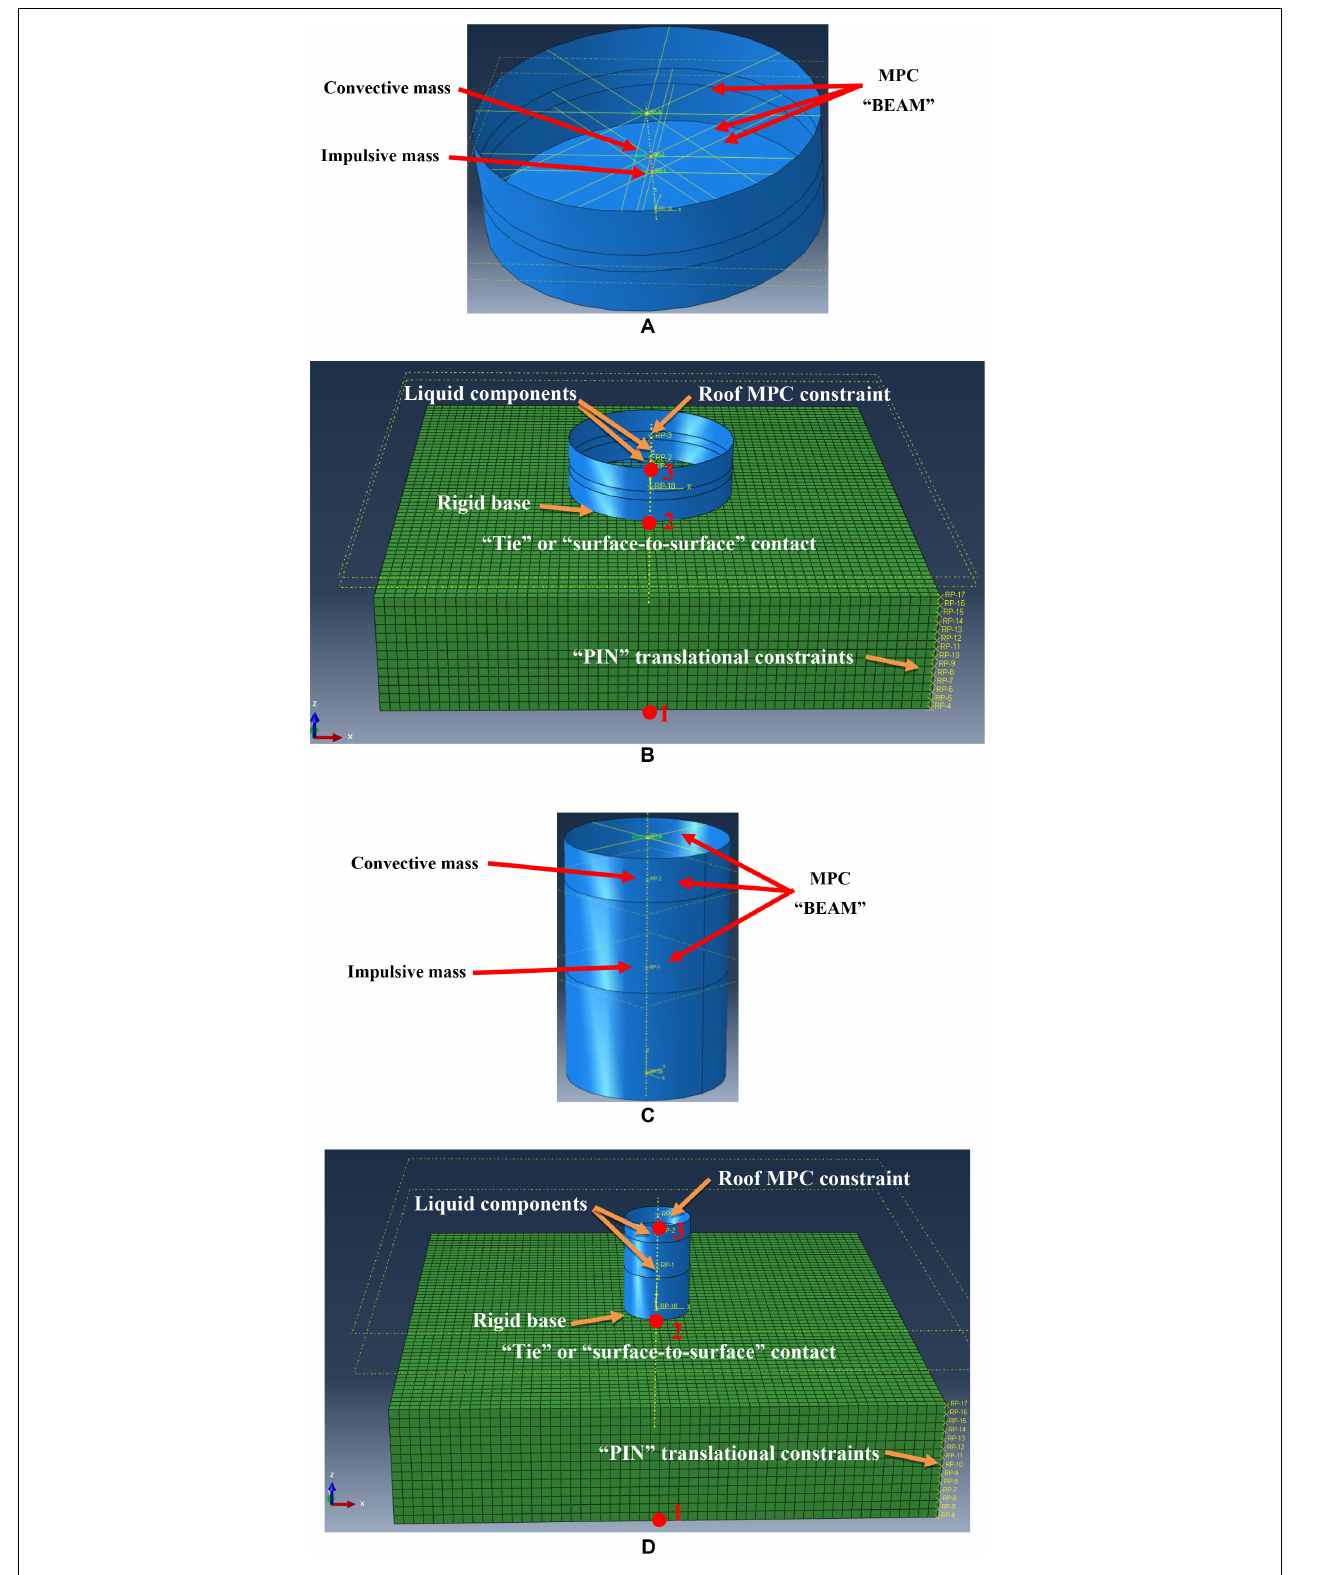
FIGURE 1 | Simplified tank and coupled soil-superstructure models for the squat (A,B) and the slender tank (C,D) .